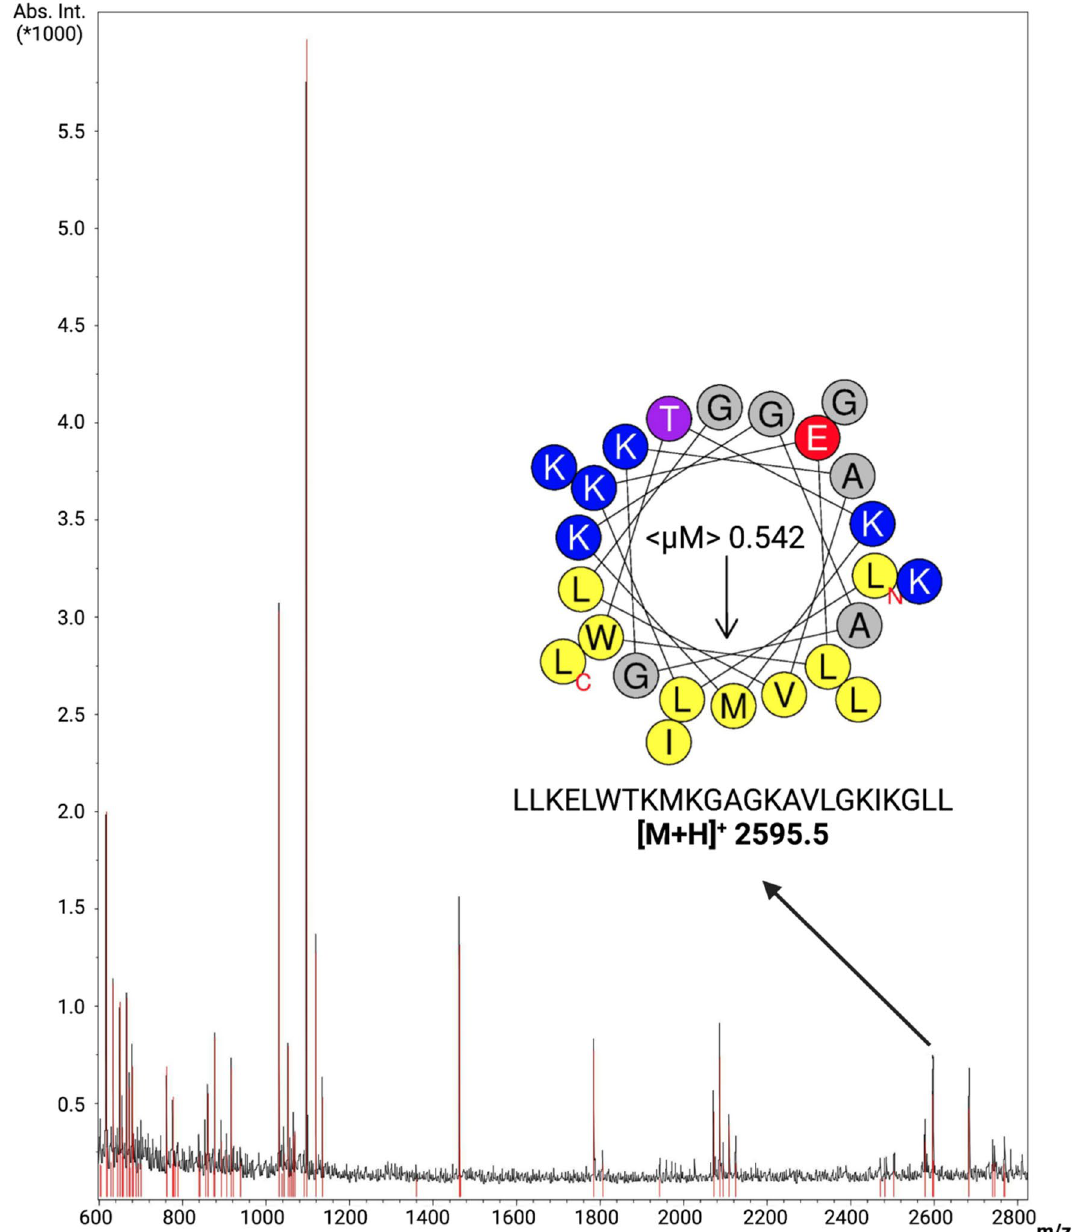
of 2595.5 m/z is represented, corresponding to the peptide sequence LLKELWTKMKGAGKAVLGKIKGLL, previously described as ponericin L1 (an AMP isolated from ant venom). The helical wheel diagram is also shown. < μM > = hydrophobic